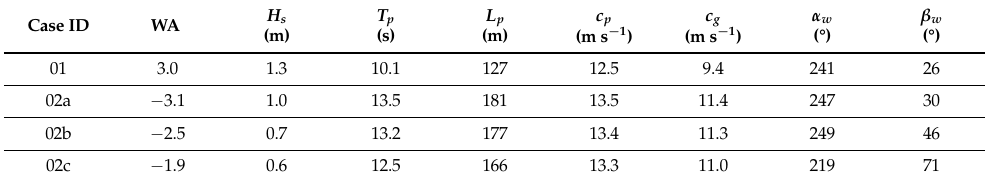
Table 3. Summary of the sea-state parameters for each test case. Wave age (WA); significant height H s , wave peak period T p and length L p , phase and group velocities c p and c g , mean wave direction α w , and directional spreading β w